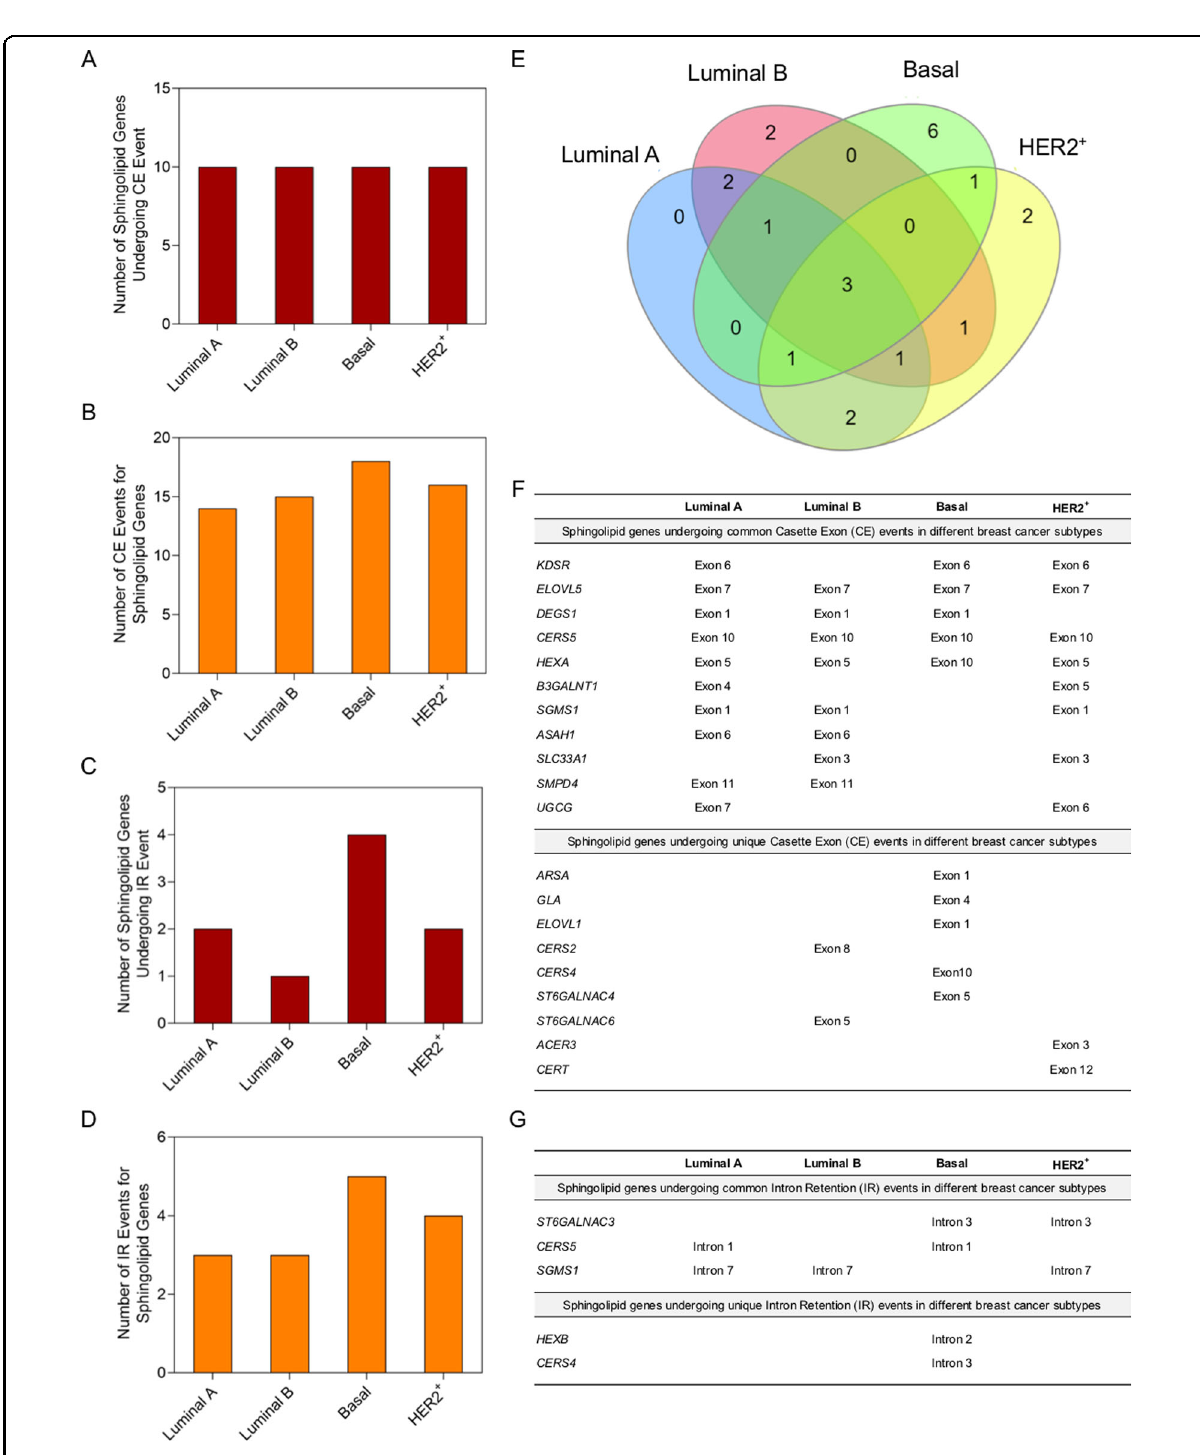
Fig. 2 Alternative Splicing in sphingolipid genes generate a breast cancer subtype-speci fi c signature. A – D Number of AS events in sphingolipid-metabolizing genes in breast cancer subtypes (TCGA-BRCA dataset) compared to normal-like breast tissue samples, as shown by differential usage of cassette exons (CE) ( A , B ) or by intron retention (IR) ( C , D ) events. Total number of Cassette Exon (CE) ( B ) and Intron Retention (IR) ( D ) events are shown for Luminal A, Luminal B, HER2 + , and Basal subtypes, and total number of genes that they correspond to ( A , C ). Statistical test Irwin – Hall p -value summarization was used on individual splicing events. E Venn diagram showing the number of common and unique AS events in sphingolipid genes in different breast cancer subtypes (TCGA-BRCA dataset). F , G List of all CE ( F ) and IR events ( G ) in different sphingolipid- metabolizing genes in different breast cancer subtypes suggesting a subtype-speci fi c AS